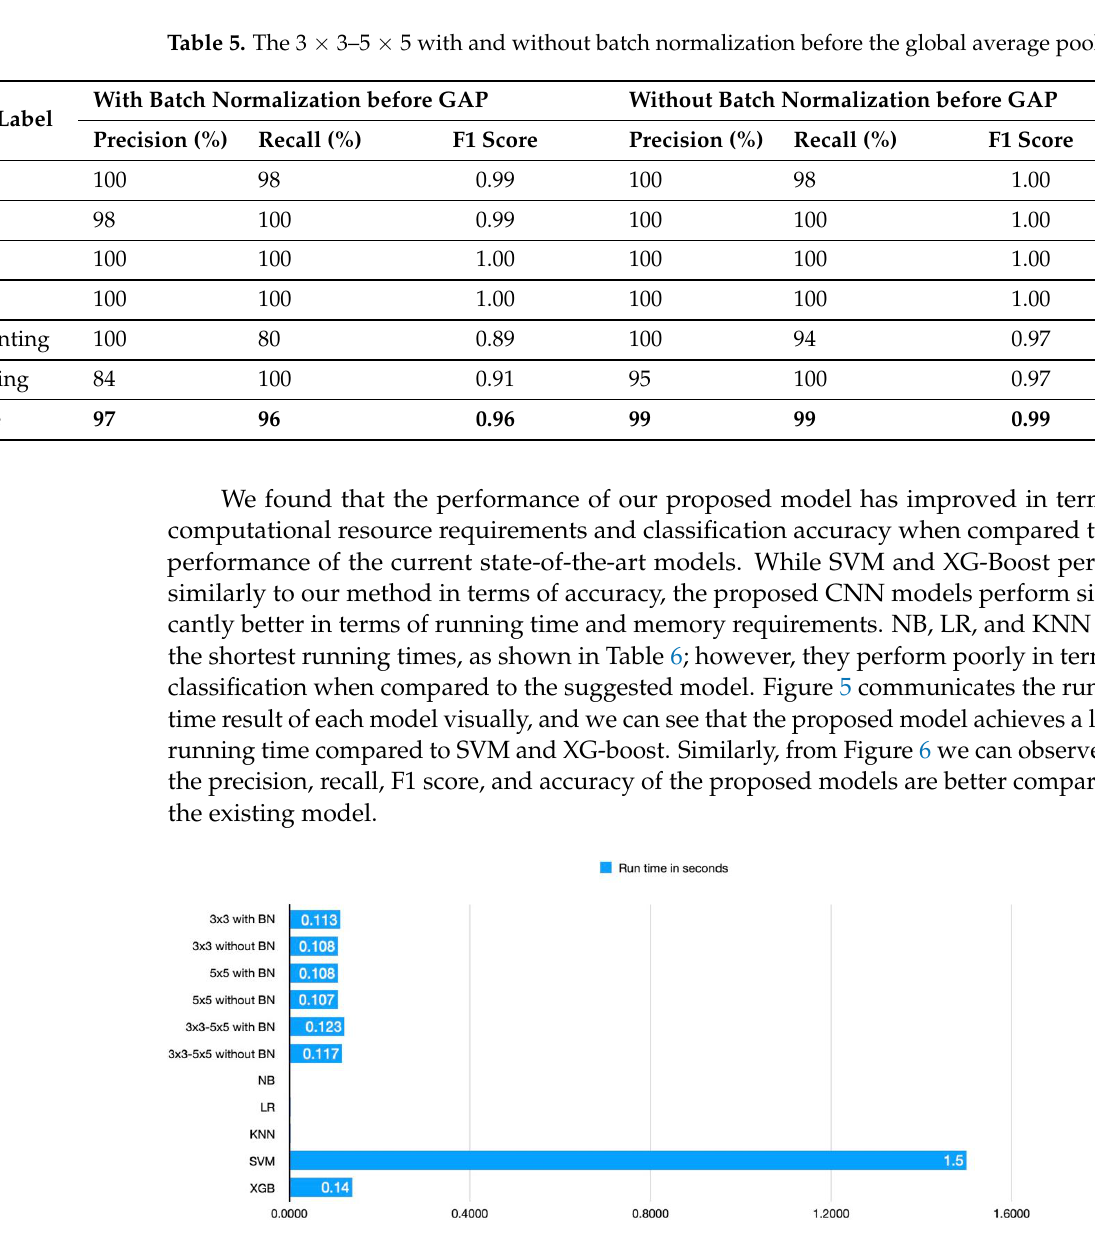
Figure 5. Comparison of models in terms of run